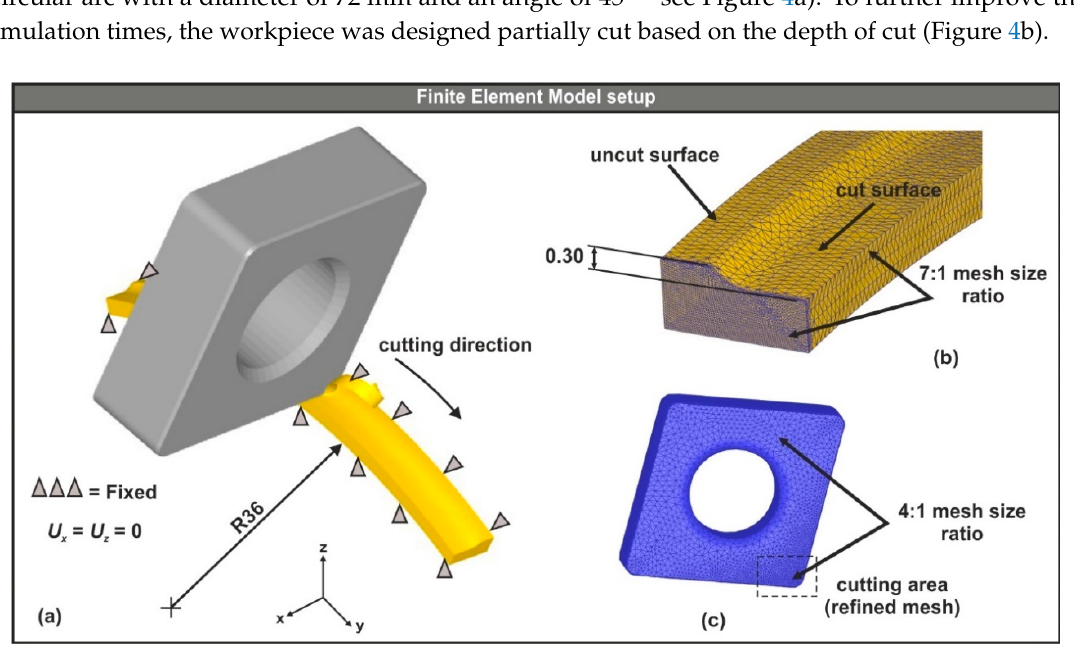
Figure 3. ( a ) The physical model of the CNGA120408T01020 ceramic and ( b ) the analogous CAD model with detailed geometry.